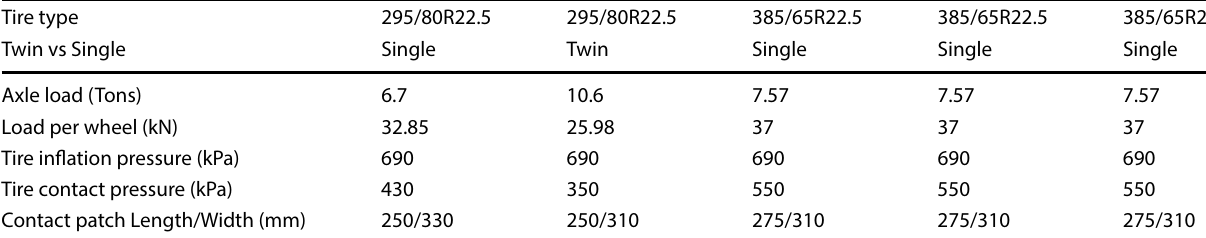
Table 4 Tire pressure and load details for the Class-1 truck